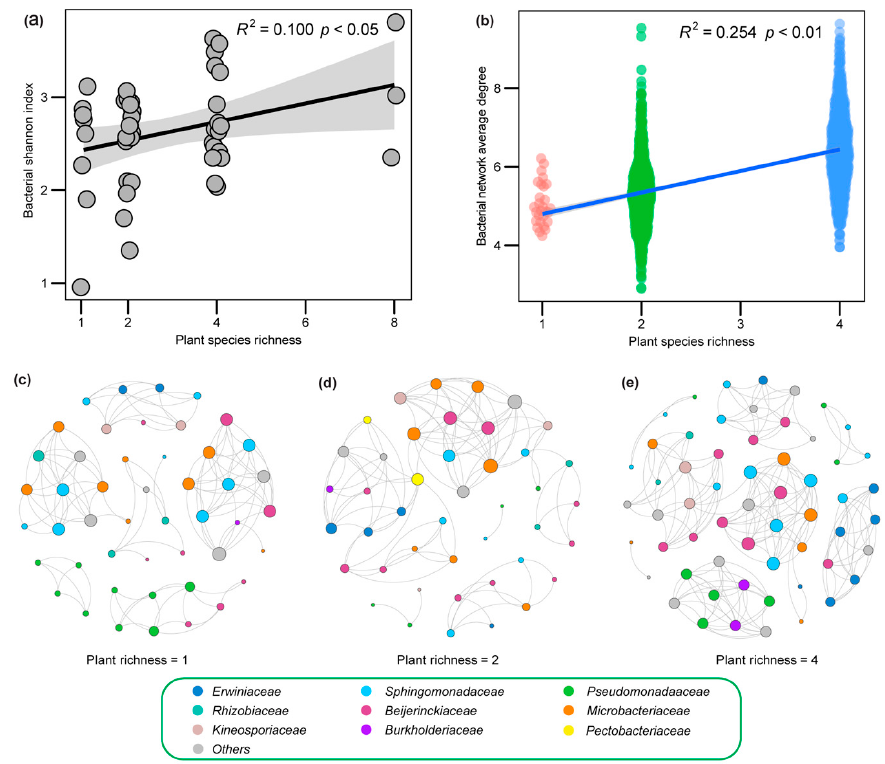
Figure 2. Alpha diversity and network complexity of leaf bacteria community of the invader along the native plant species richness gradient. ( a ) The relationship between bacterial alpha diversity and